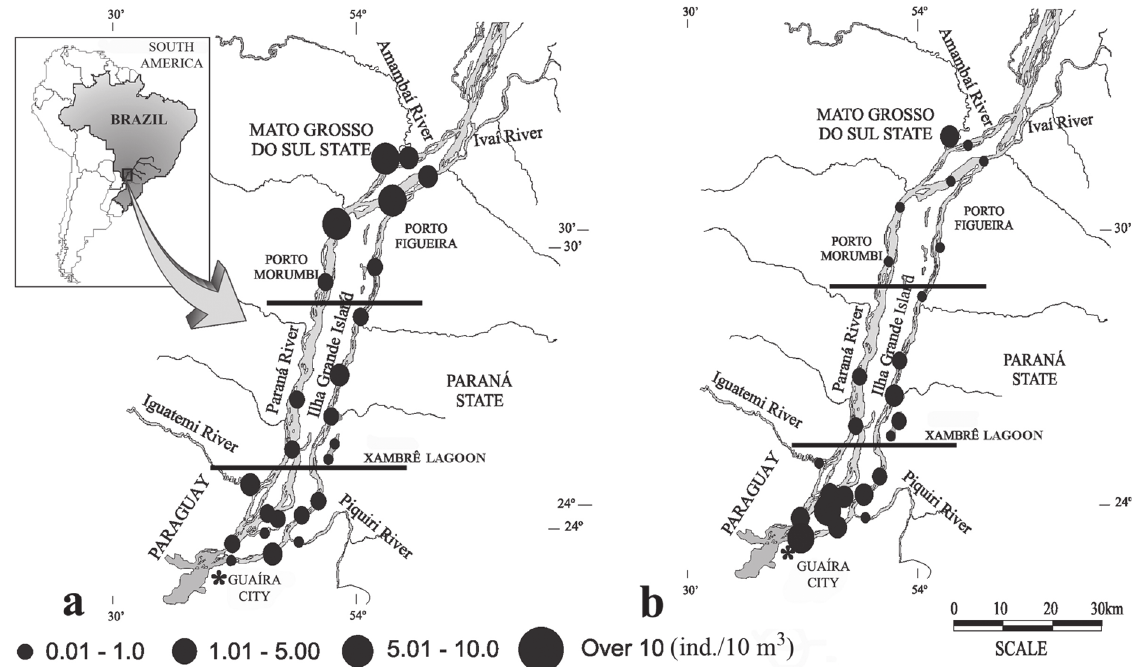
Fig. 4. Average abundance of fish eggs ( a ) and larvae ( b ) in the Ilha Grande National Park, from October 2001 to March